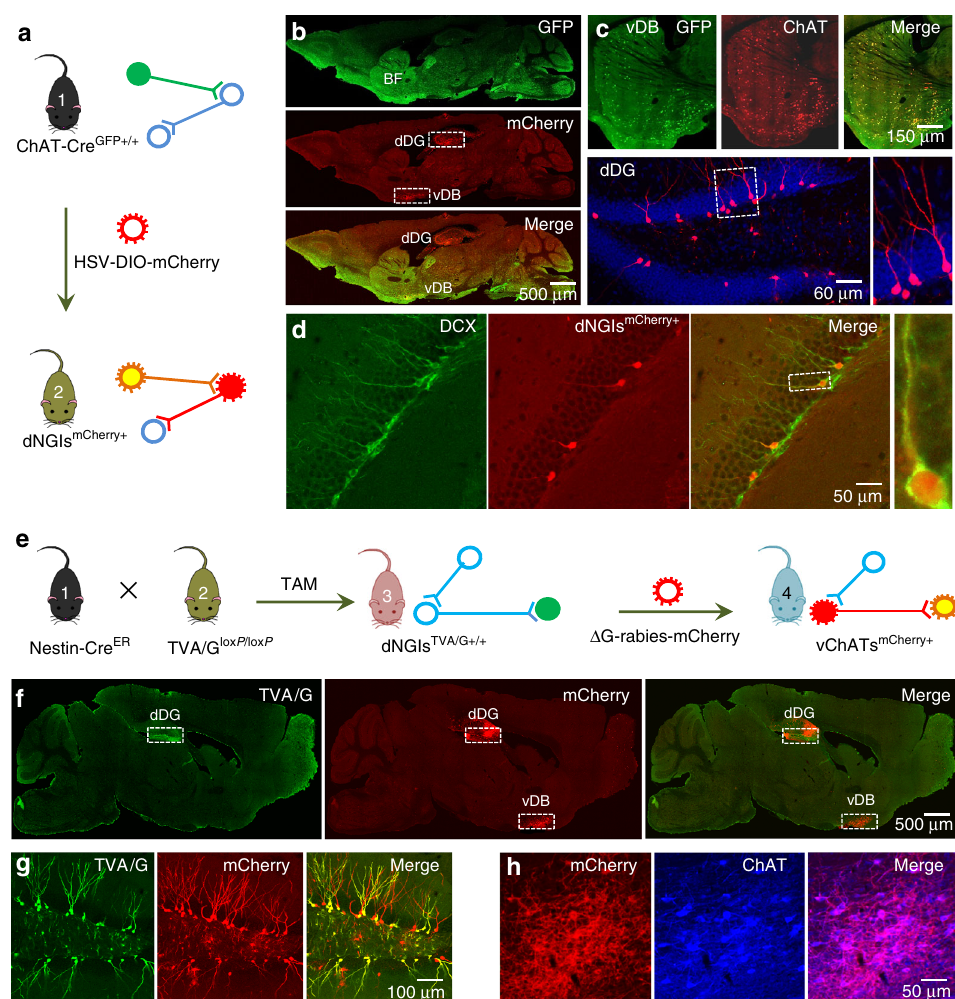
Fig. 1 vChATs directly innervate dNGIs. a Monosynaptic anterograde tracing strategy shows the application of HSV-DIO-mCherry virus in ChAT-Cre GFP+/+ mice for labeling postsynaptic cells (red) of vChATs (yellow). b A brain section (top) from a ChATs-Cre GFP+/+ mouse shows GFP expression (green, top). 3 days after the injection of HSV-DIO-mCherry virus (0.2 μ l), mCherry-expressing cells were detected in both the vDB (top) and dDG (red, middle and bottom) regions of ChAT-Cre GFP+/+ mice. c GFP-expressing ChATs (green) in the section stained with anti-ChAT (red) in the vDB region (top). The mCherry-expressing cells (red) in the sub-granular zone of the dDG region stained with DAPI (blue, bottom). d The mCherry-expressing cells in the dDG region are co-labeled with anti-DCX (blue). e Monosynaptic retrograde tracing strategy shows that NGI TVA/G+/+ mice were generated by crossing Nestin- Cre ER mice with TVA/G lox P /lox P mice. Following the administration of tamoxifen (TAM), Δ G-rabies-mCherry virus particles (red) were injected into the dDG region of the NGI TVA/G+/+ mice for labeling presynaptic cells (red) of dNGIs (yellow). f A brain section reveals the TVA/G-GFP cells (green) in the dDG region and mCherry in both the dDG and vDB of a dNGI TVA/G+/+ mouse 3 days after injection of the Δ G-rabies-mCherry virus particles (1.5 μ l). g TVA/G +/+ cells (green) in the dDG region were co-labeled with mCherry from the dNGI TVA/G+/+ mice 3 days after injection of the Δ G-rabies-mCherry virus. h The mCherry + cells (red) in the vDB region were co-labeled with anti-ChAT (blue) from the dNGI TVA/G+/+ mice 3 days after injection of the Δ G- rabies-mCherry virus. a – h , similar results were seen in each of fi ve